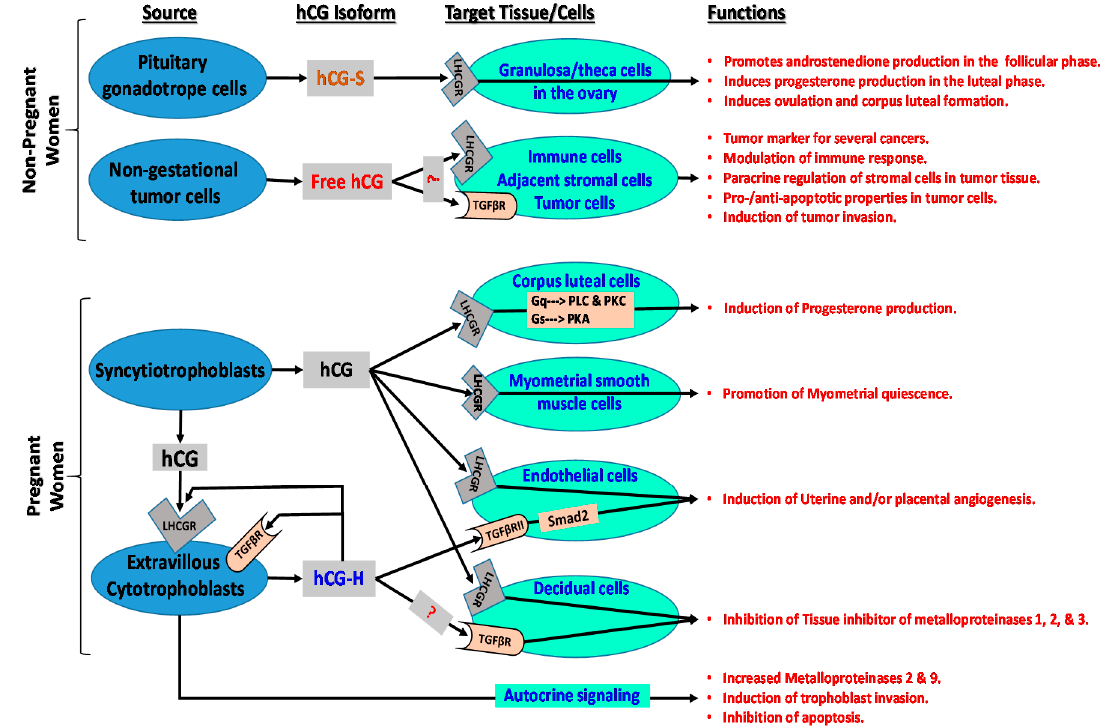
Figure 1. Cellular sources, targets, associated signaling cascades, and functions of various hCG isoforms in non-pregnant and pregnant women. LHCGR: luteinizing hormone/choriogonadotropin receptor; TGF β R: transforming growth factor beta receptor; ?: hCG may bind to relevant receptor in target cells; Smad2: similar to drosophila gene ‘mothers against decapentaplegic’ 2; Gq: heterotrimeric G protein subunit that activates phospholipase C (PLC)-associated protein kinase C (PKC); Gs: heterotrimeric G protein subunit that activates cAMP-dependent protein kinase A (PKA) signaling by activating adenylyl cyclase; hCH-S: sulfated hCG; hCG-H: hyperglycosylated hCG.